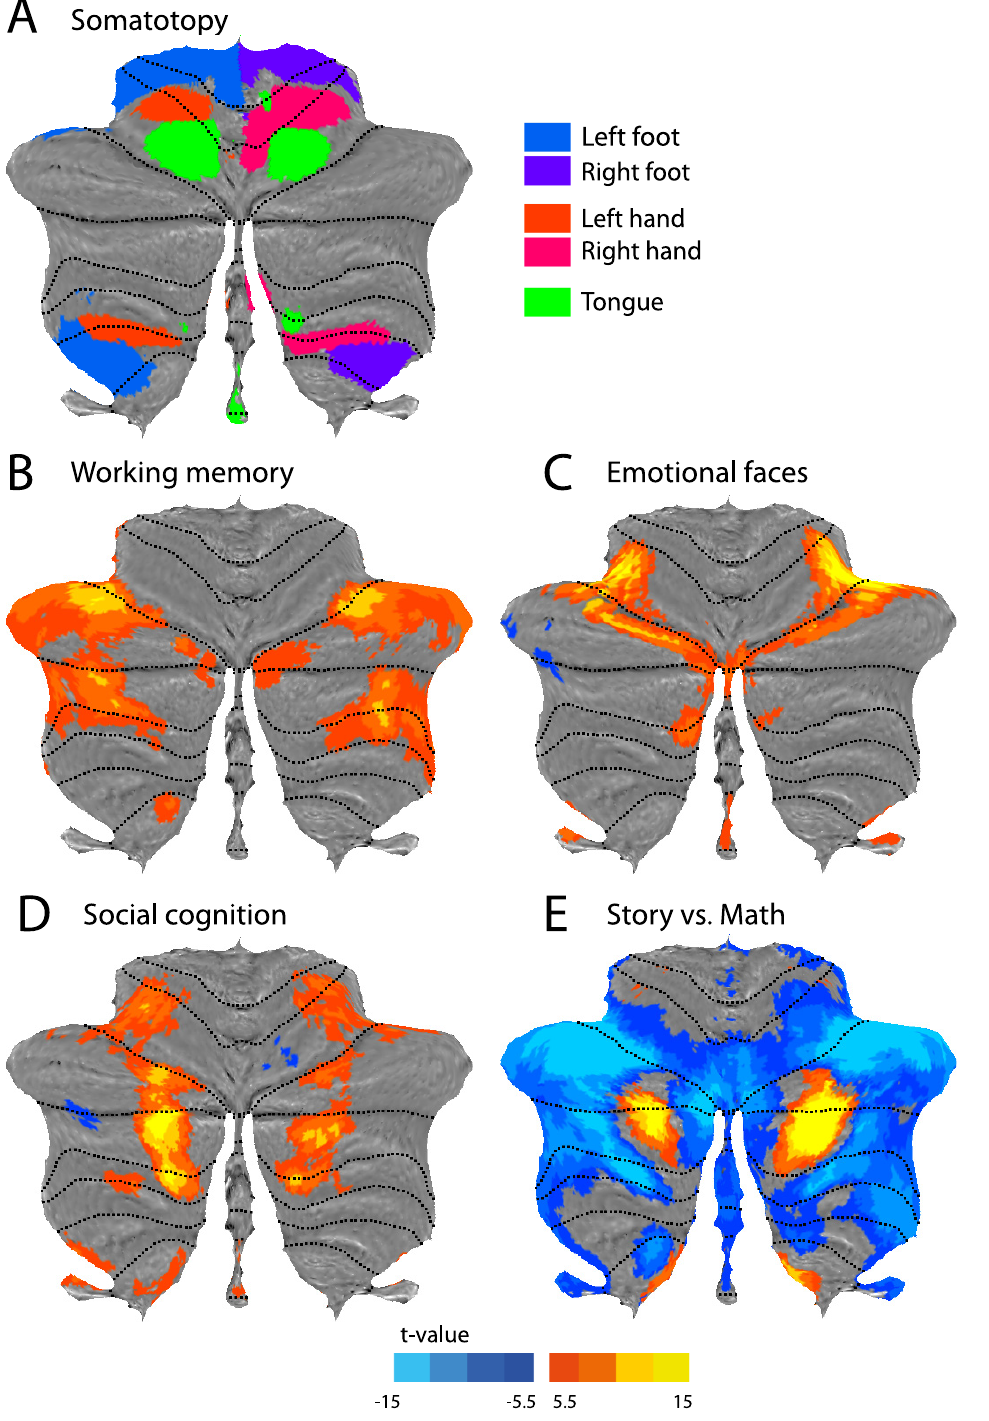
Fig 7. Functional activity maps from the Human Connectome Project. ( A ) Sensorimotor topography of activation for hand, foot and tongue movements. ( B ) Working memory; contrast between a 2-back and 0-back condition. ( C ) Emotion processing; contrast between matching emotional faces vs. matching neutral shapes. ( D ) Social cognition; observing dot motion with intentional content vs. random dot motion. ( E ) Language vs. mathematical processing. Positive values indicate higher activity during processing of a story vs. arithmetic operations. Negative values represent the opposite contrast. All maps are based on N = 100 subjects. All colored areas in cognitive maps (B-E) exceed an FWE-corrected significance threshold of p < 0.05.